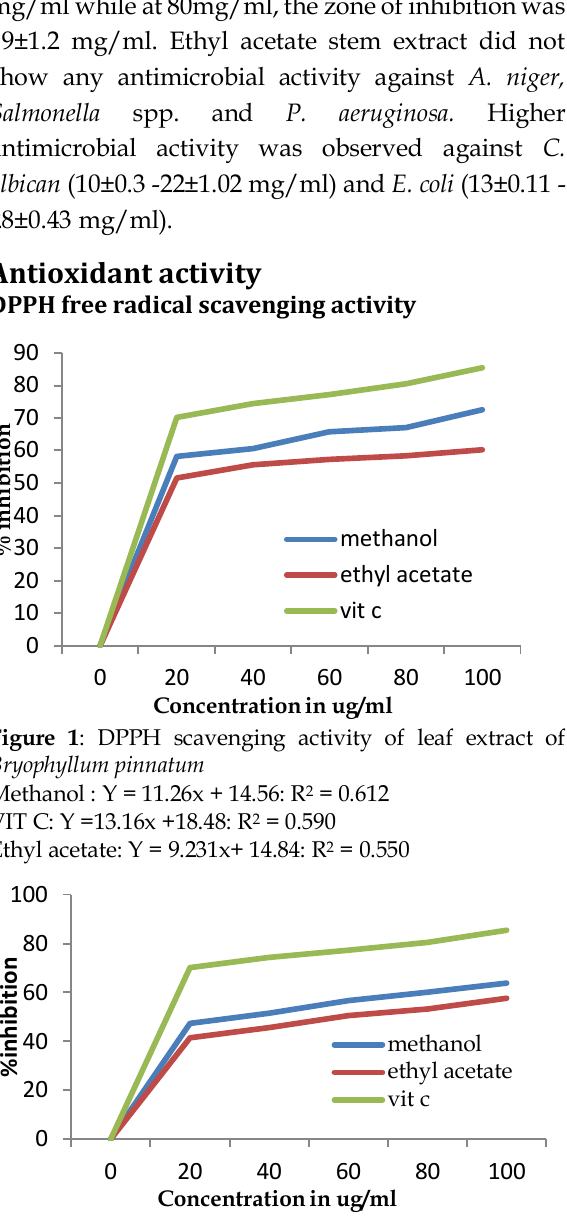
Figure 2 : DPPH scavenging activity of stem extract of Bryophyllum pinnatum Methanol: Y = 10.36x + 10.28; R 2 =0.677 Ethyl acetate Y = 9.365X +8.62; R 2 = 0.693